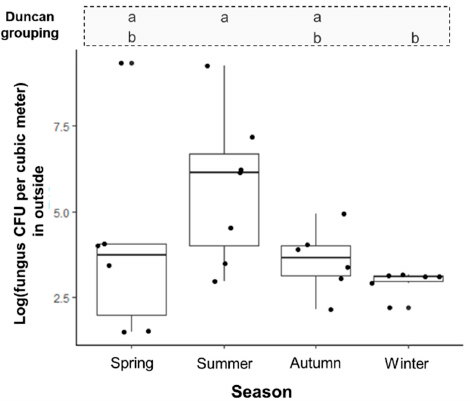
Figure 2. Seasonal variability of log fungal (CFU/m 3 ) in the outside of hospital. Abbreviations: a, b: same group symbols by Duncan’s post hoc analysis, respectively.